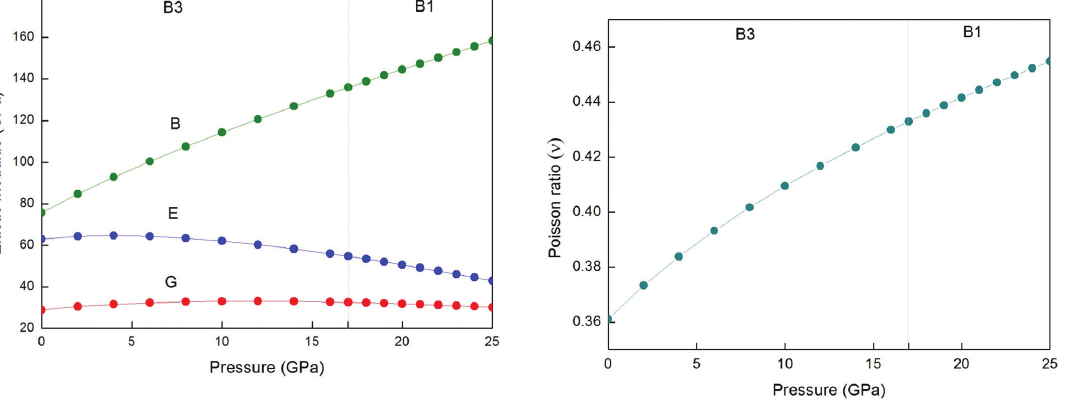
Figure 4. Pressure dependence of elastic moduli B, E, and G in GaAs.